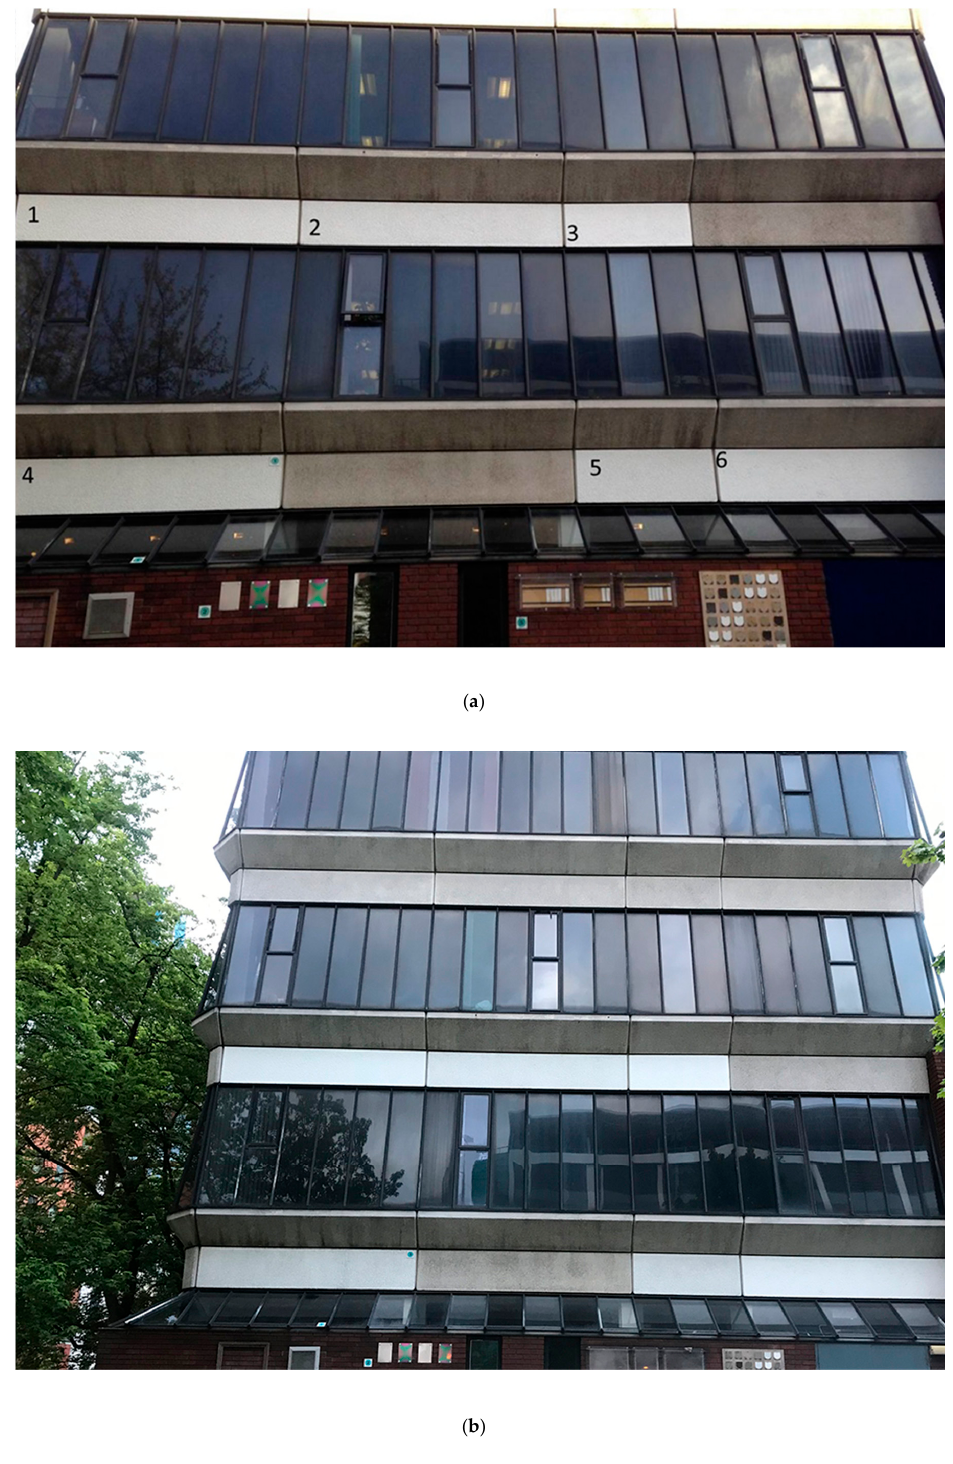
Figure 5. Images of the wall at Manchester Metropolitan University used in the study of photocatalytic paint (panels labelled 1–6). Panels 1, 3 and 6 were painted with photocatalytic paint, whilst panels 2, 4 and 5 were painted with paint that did not contain the photocatalytic agent. The image on the top ( a ) was taken in 2014, eight months following the application of the paint: whiteness / brightness di ff erence between the two paint types is hard to distinguish. The lower image ( b ) was taken six years later (2020); panels painted with photocatalytic paint are visibly brighter compared to control paint